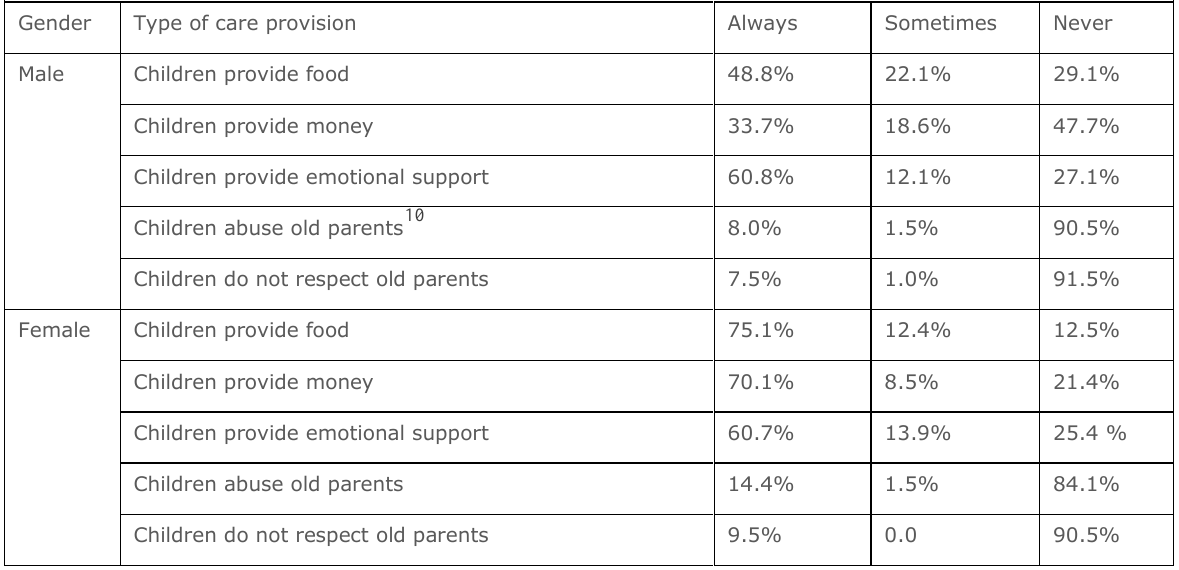
Table 8: The provision by gender of elderly care to those who live in coresidence Gender Type of care provision